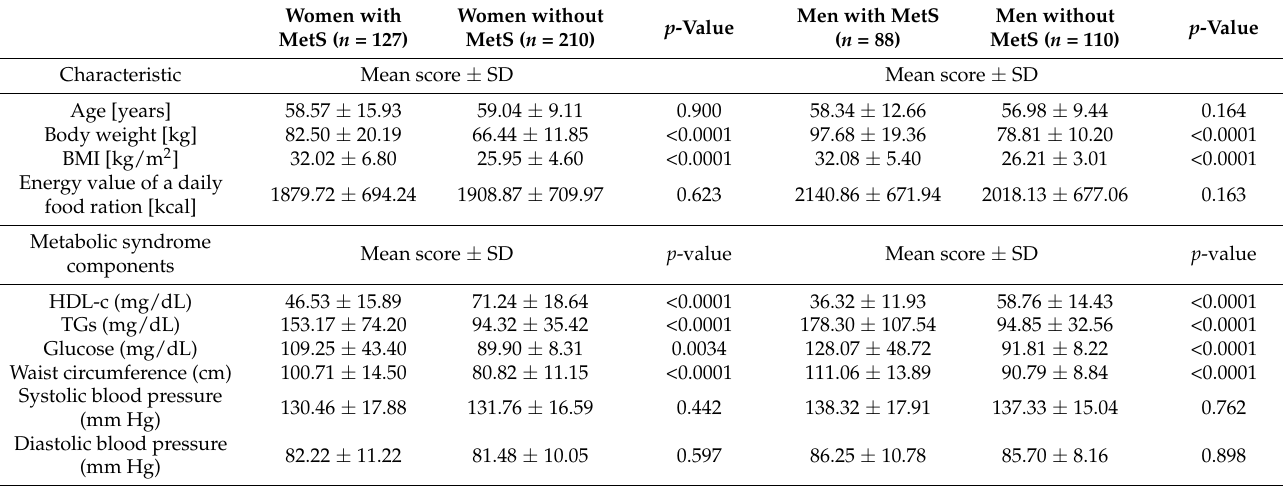
Table 1. Characteristics of the study and control groups, stratified by gender and diagnosis of the metabolic